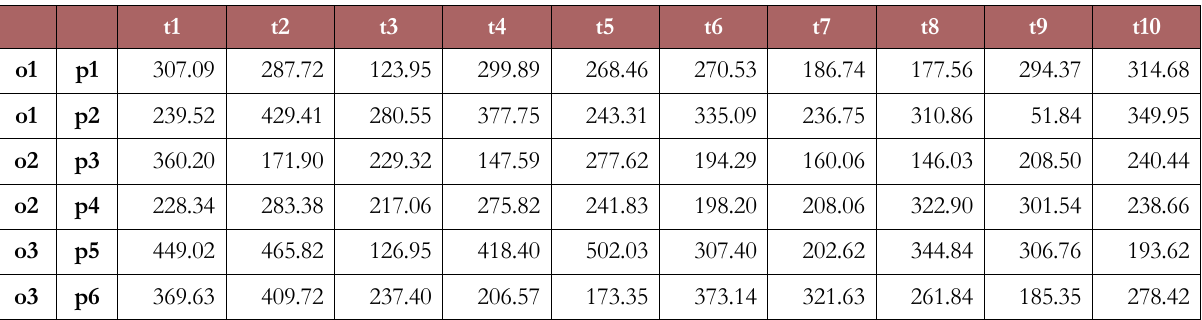
Table 5. Real demand DR